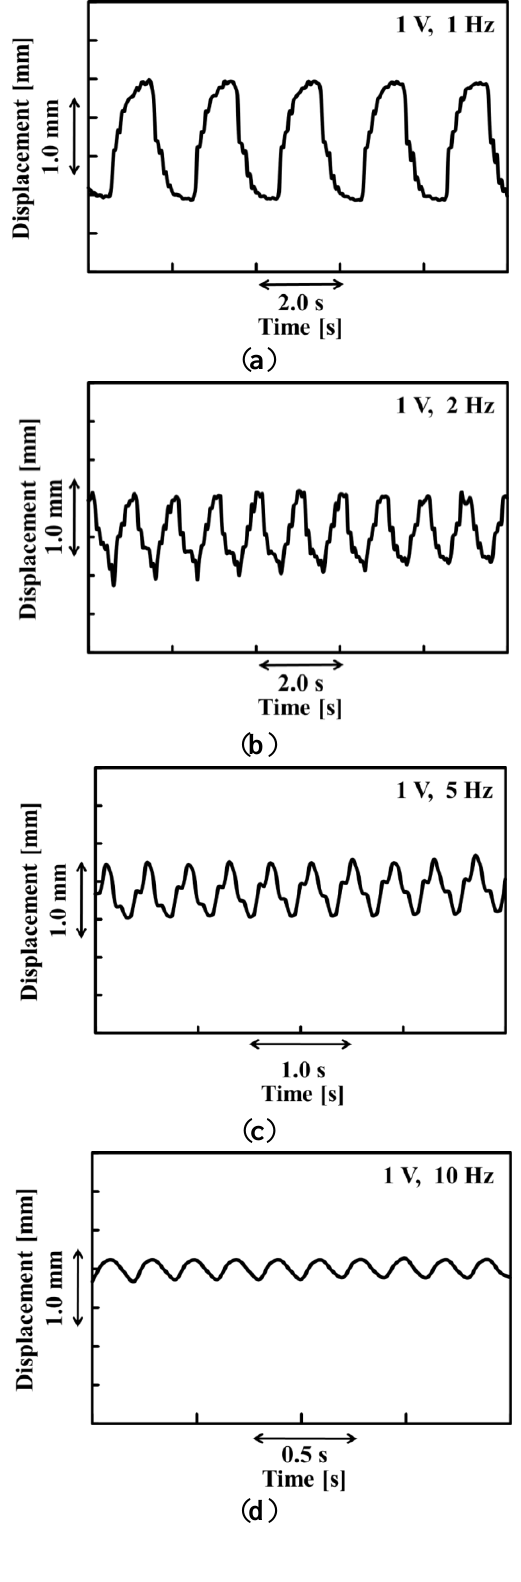
Figure 3. Time dependence of the displacement of the PEDOT/PSS paper actuator at 1 V applied voltage and a frequency of ( a ) 1, ( b ) 2, ( c ) 5, and ( d ) 10